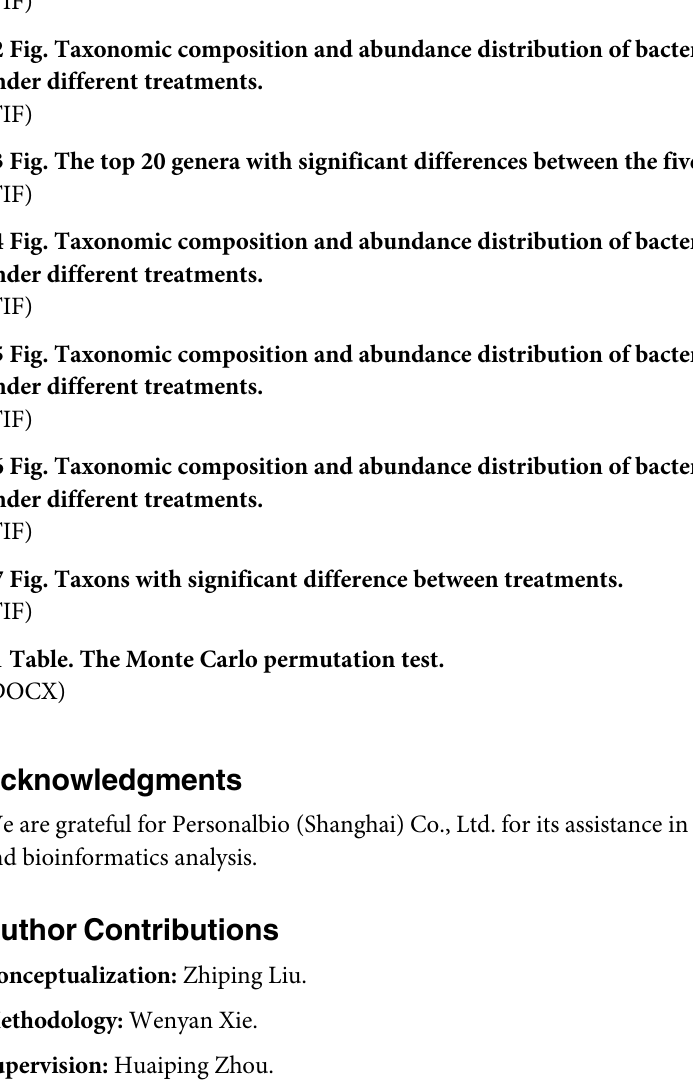
S1 Fig. Species accumulation curve of bacteria. (TIF) S2 Fig. Taxonomic composition and abundance distribution of bacteria at the genus level under different treatments. (TIF) S3 Fig. The top 20 genera with significant differences between the five treatments. (TIF) S4 Fig. Taxonomic composition and abundance distribution of bacteria at the class level under different treatments. S5 Fig. Taxonomic composition and abundance distribution of bacteria at the order level under different treatments. S6 Fig. Taxonomic composition and abundance distribution of bacteria at the family level under different treatments. S7 Fig. Taxons with significant difference between treatments. (TIF) S1 Table. The Monte Carlo permutation test.